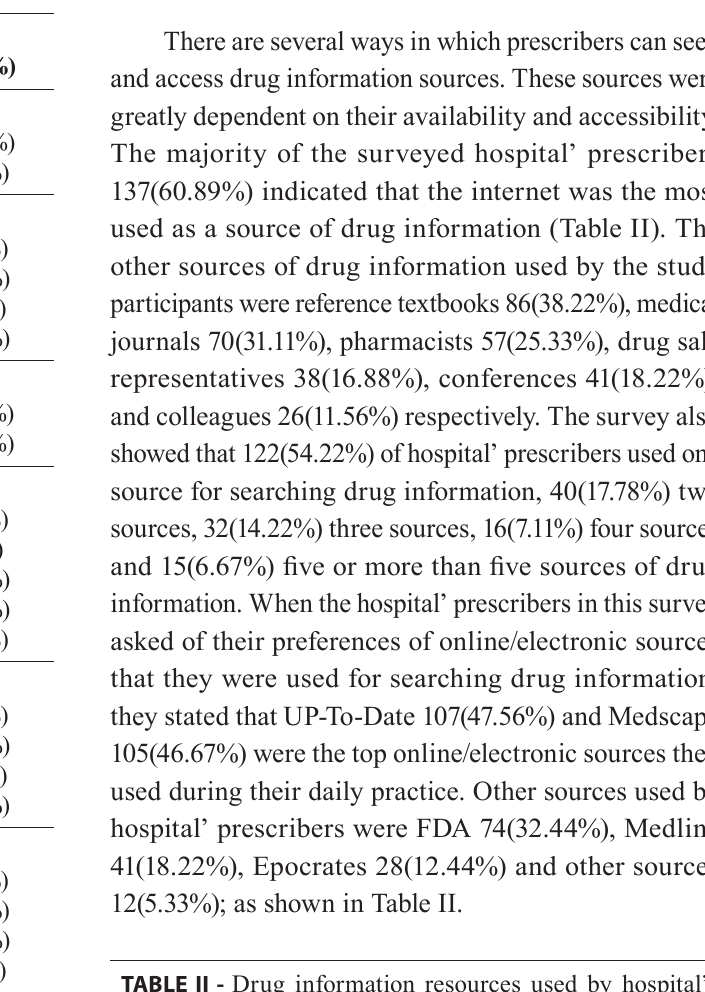
TABLE I - D emographic characteristics of